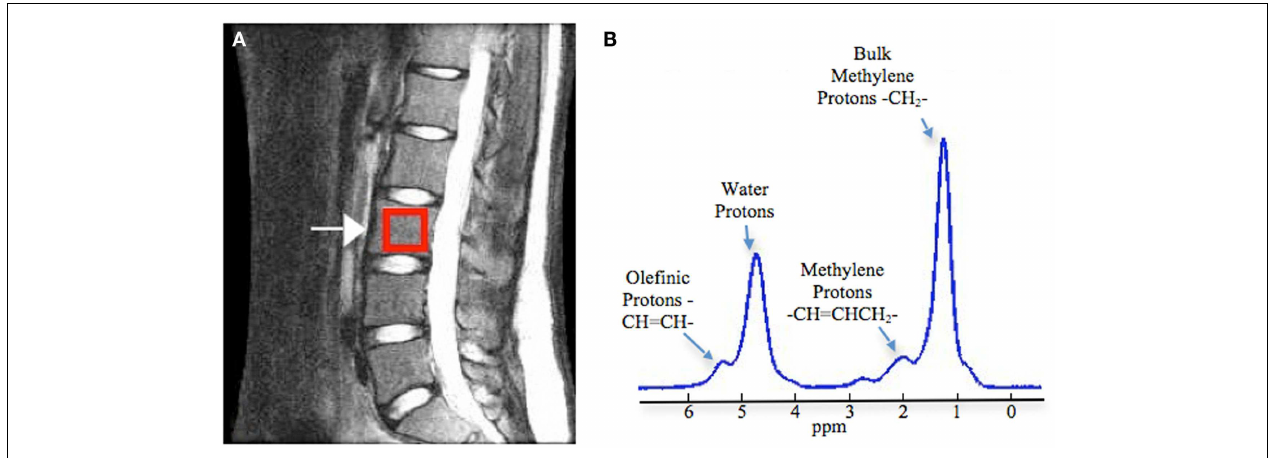
–CH = CH– protons at 5.31ppm, water protons at 4.65ppm, the CH 2 methylene protons α to a double bond (–CH = CHCH 2 –), at 2.03ppm, and the bulk CH 2 methylene protons at 1.3ppm. Adapted with permission from Ref.